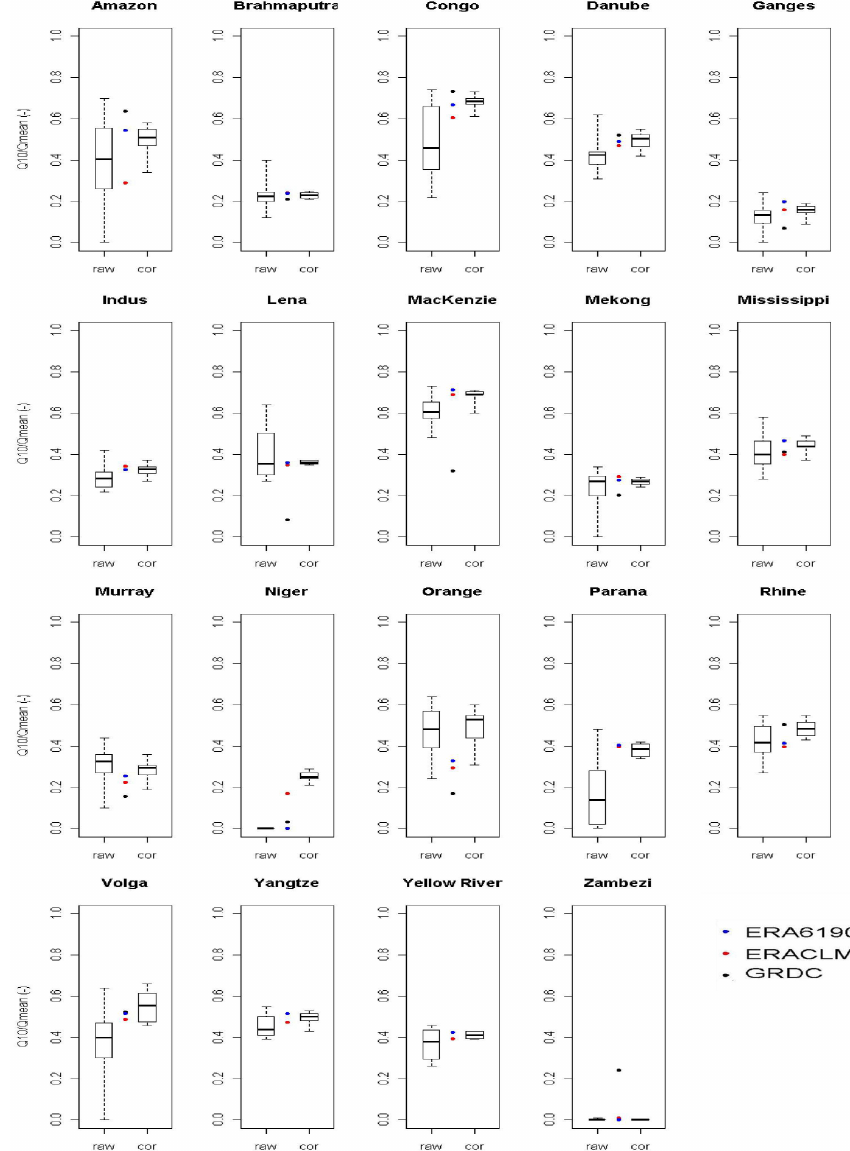
Fig. 4. Thirty year average relative Q10 values ( Q 10 /Q (–)) for the ensemble of non-bias corrected GCM runs (raw) and bias-corrected GCM runs (cor; boxes are drawn between the quartiles and whiskers represent minimum and maximum values), the ERA6190 run (blue points), the ERCLM run (red points) and the GRDC observations (black points).